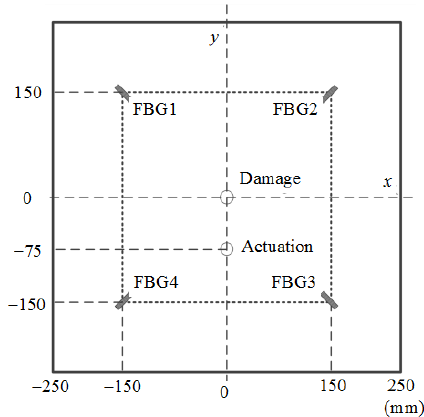
Fig. 5 Schematic of the active actuation